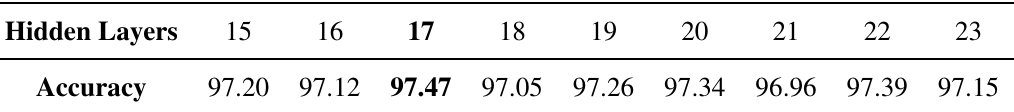
Table 5. Accuracy for a number of neurons of around